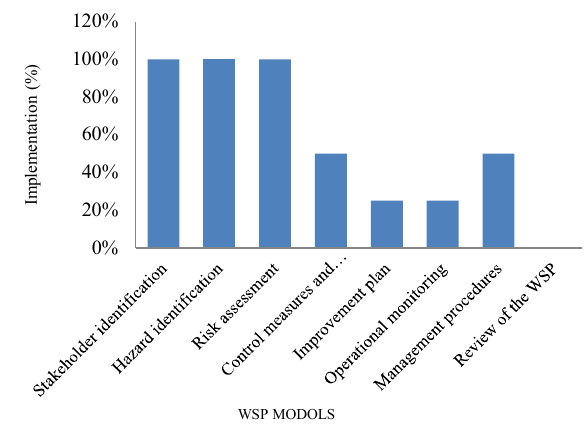
Fig. 2. Quantitative information for Catchment, Treatment, Distribution, Point of Use